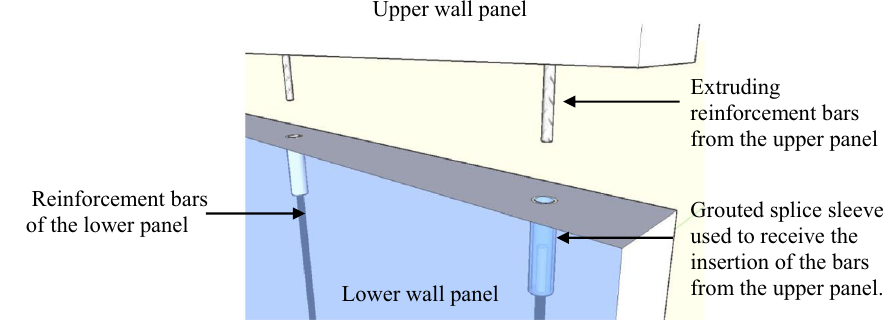
Fig. 3 Grouted splice sleeve as the connection of precast concrete wall panels (Loh